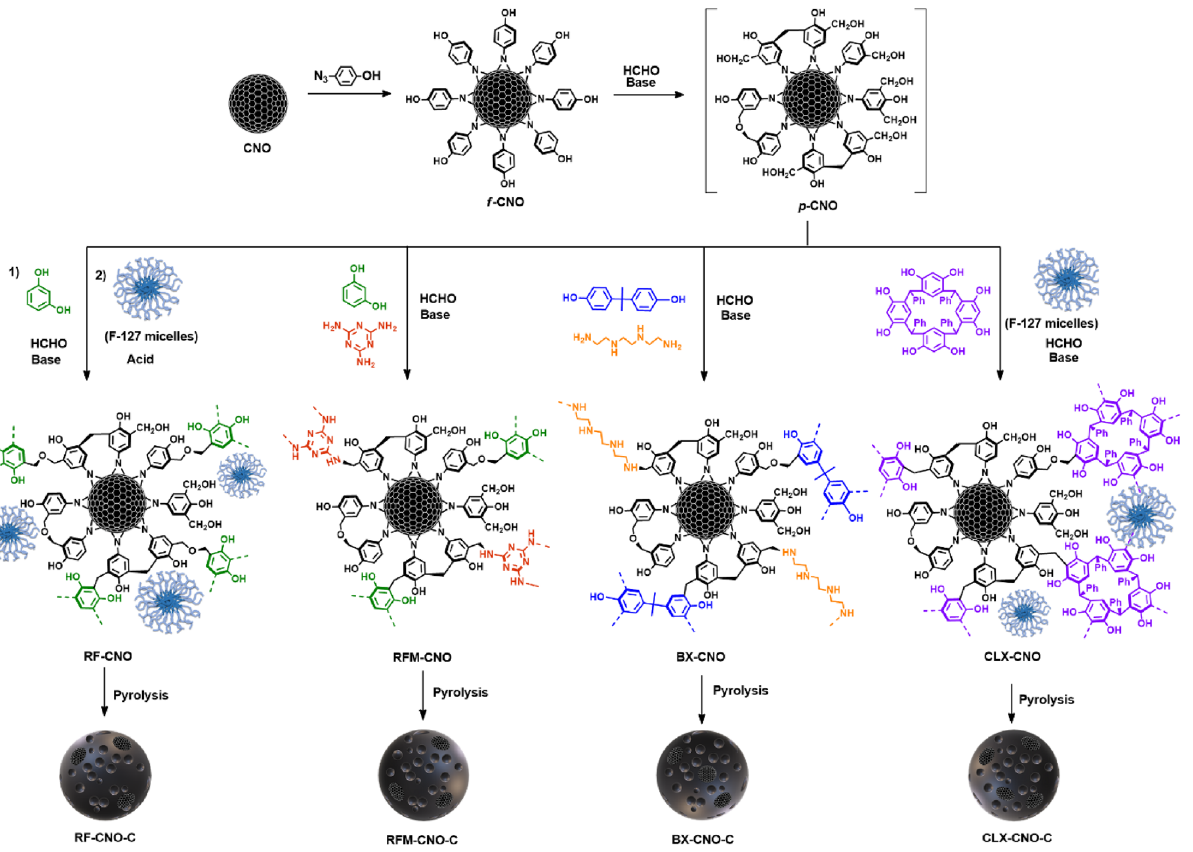
Figure 2. Representation of the CNO functionalization and synthesis of the composites containing CNO and